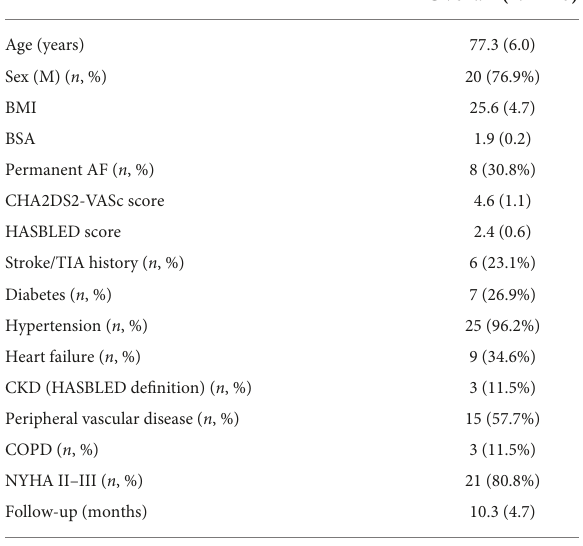
TABLE 1 Baseline